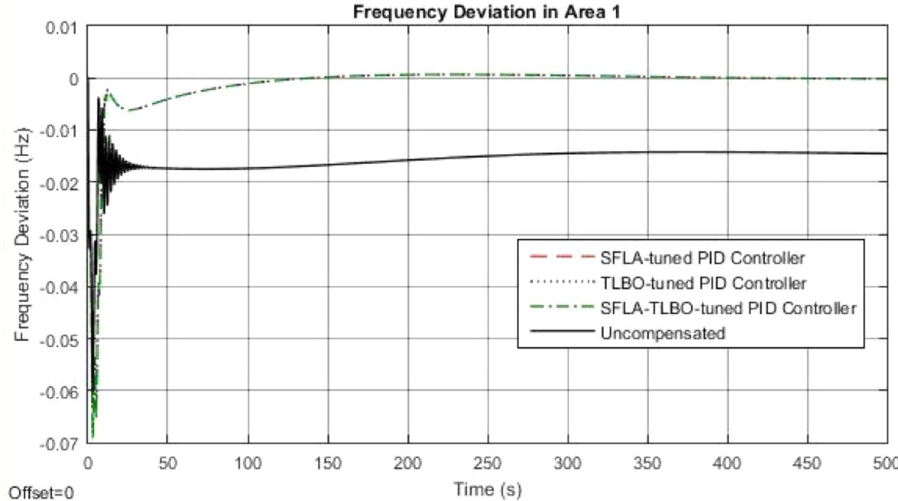
Fig. 12 Frequency deviation in area 1 for non-linear two-area